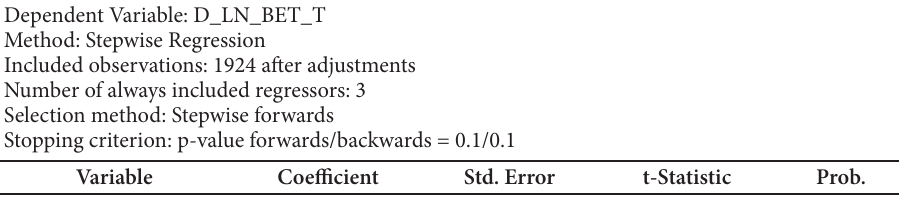
Table 2. Input variables for BET